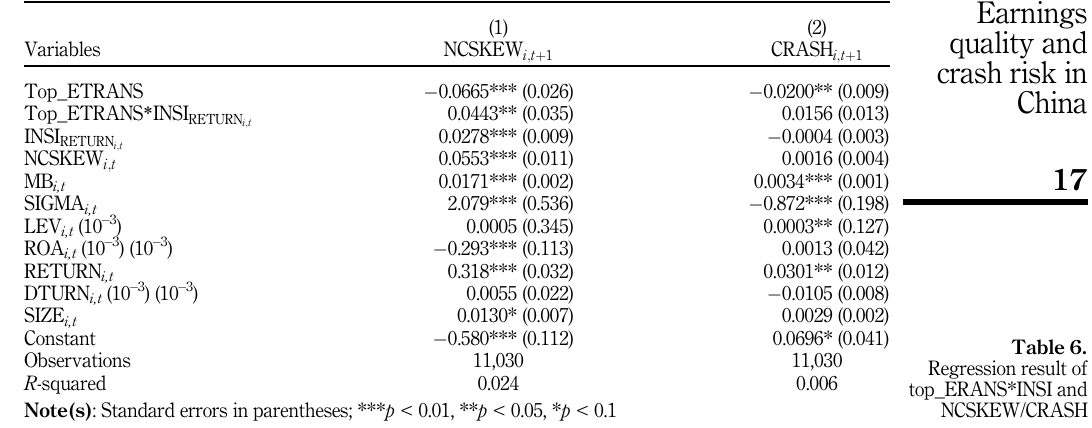
Table 6. Regression result